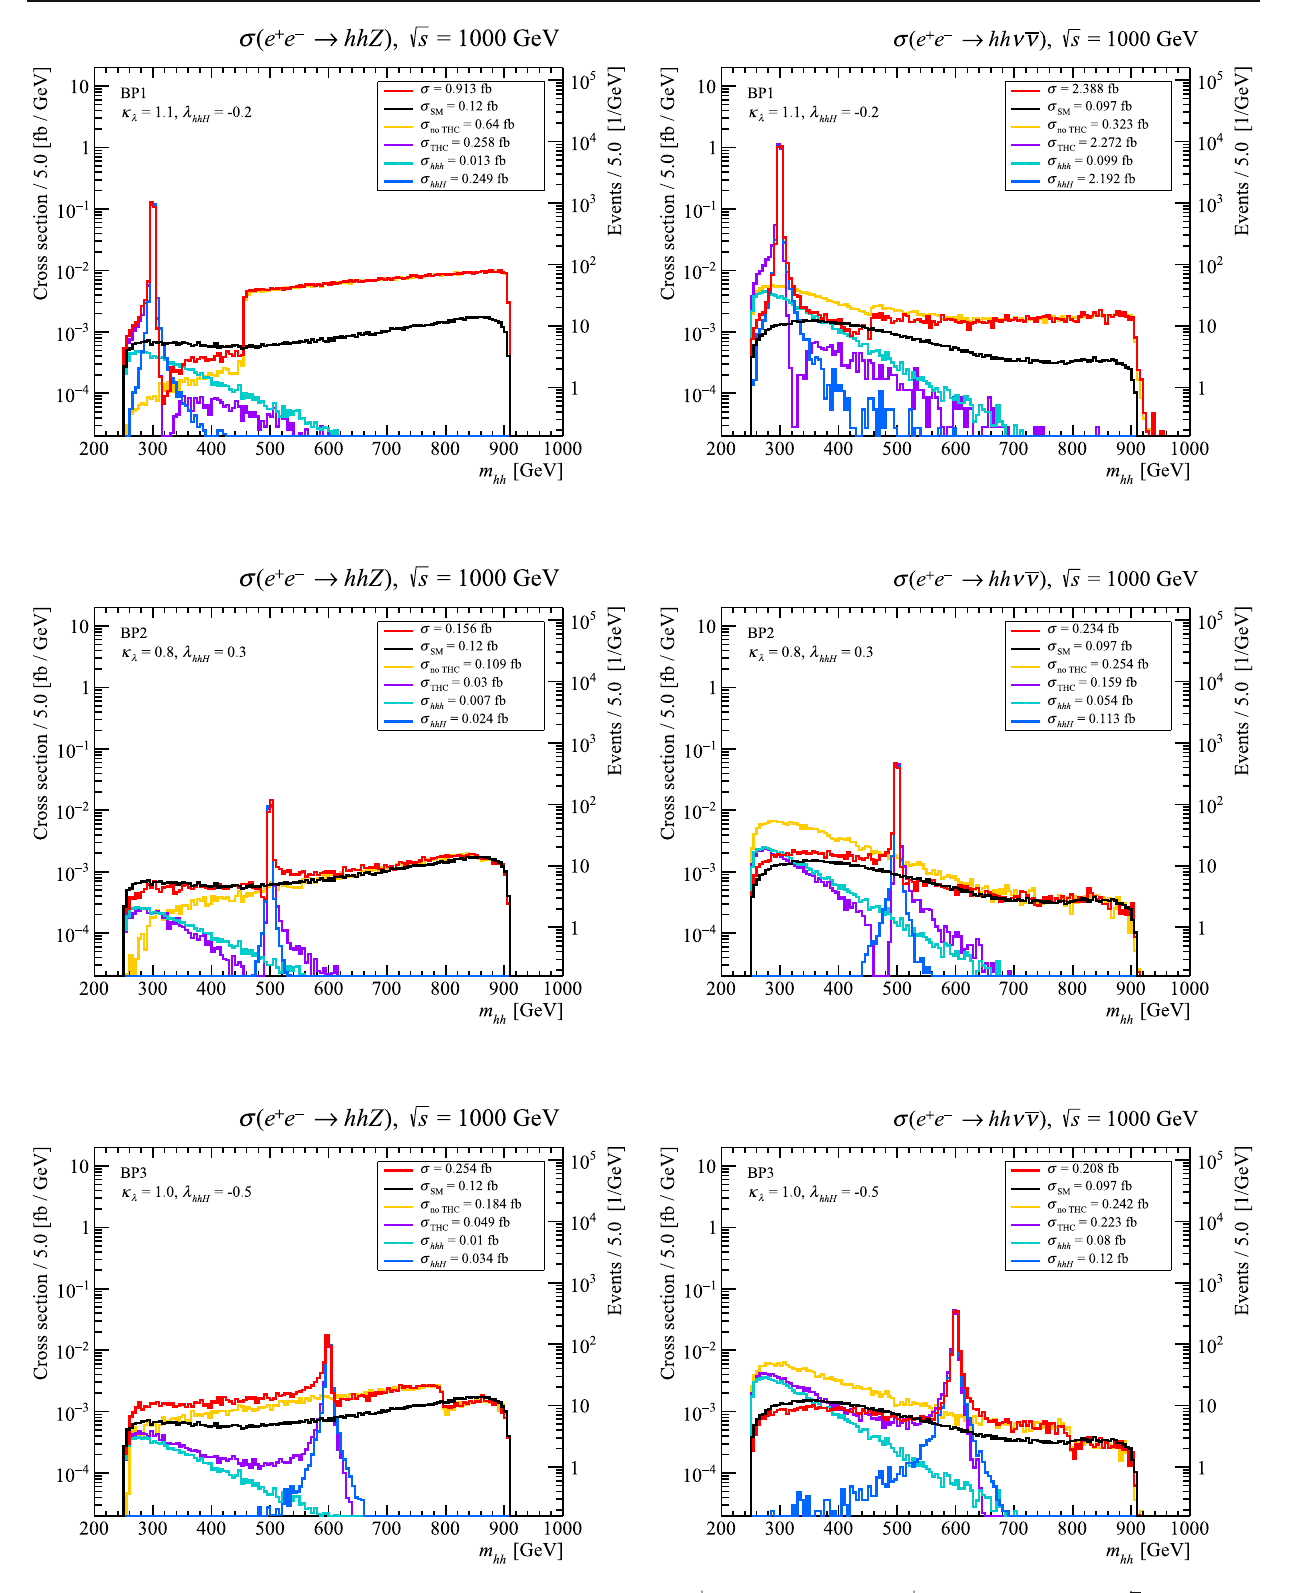
Fig. 21 Distribution on the invariant mass of the final hh pair in the process e + e − → hhZ (left) and e + e − → hh ν ¯ ν (right) at for BP1, BP2 and